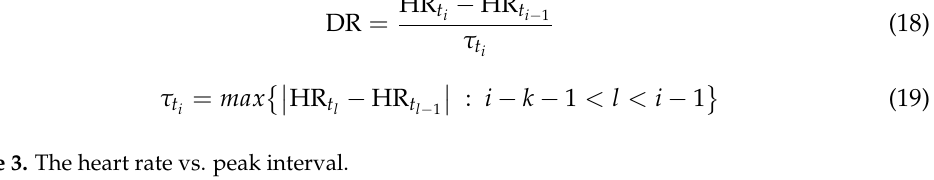
Table 3. The heart rate vs. peak interval. Peak Interval (the Range of Sample